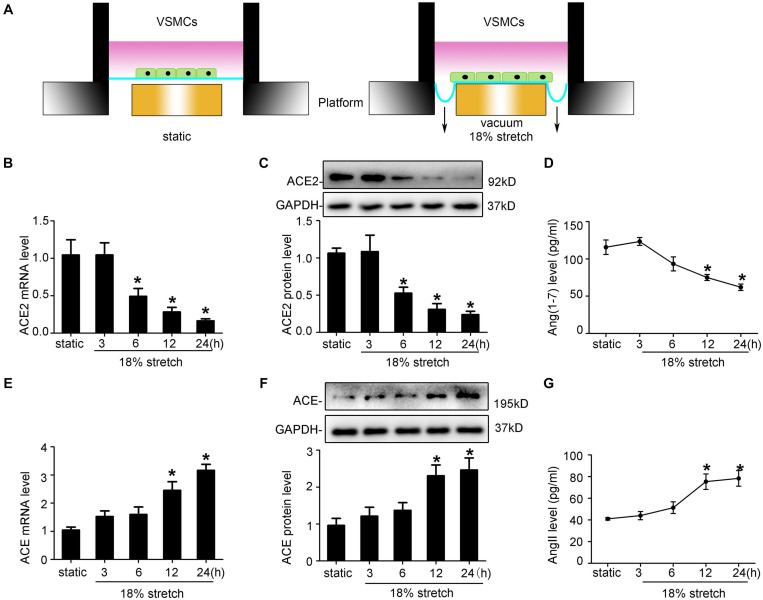
Mechanical stretch modulates ACE2, ACE, Ang-(1–7), and Ang II expression in vascular smooth muscle cells (VSMCs) in vitro. (A) Schematic diagrams of the mechanical stretch loading system in the current study. VSMCs were subjected to 18% 1 Hz mechanical stretch for the indicated time. (B,E) RT-qPCR analysis of ACE2 and ACE mRNA in VSMCs under mechanical stretch for the indicated time. (C,F) Western blot analysis of ACE2 and ACE protein expression in VSMCs under mechanical stretch for the indicated time. (D,G) Levels of AngII and Ang-(1-7) in VSMCs after exposure to mechanical stretch were assayed by ELISA. Values are expressed as means ± SEM. *P < 0.05 vs. static (n = 4).